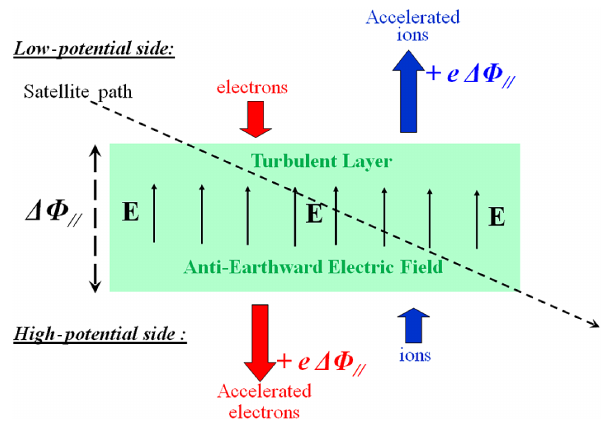
Figure 1. Idealized representation of the field-aligned potential structure in the upward-current region showing the spacecraft path across the parallel electric field layer. When electrons pass across the layer from above they become accelerated while ions are accel- erated by the same amount when passing from below.